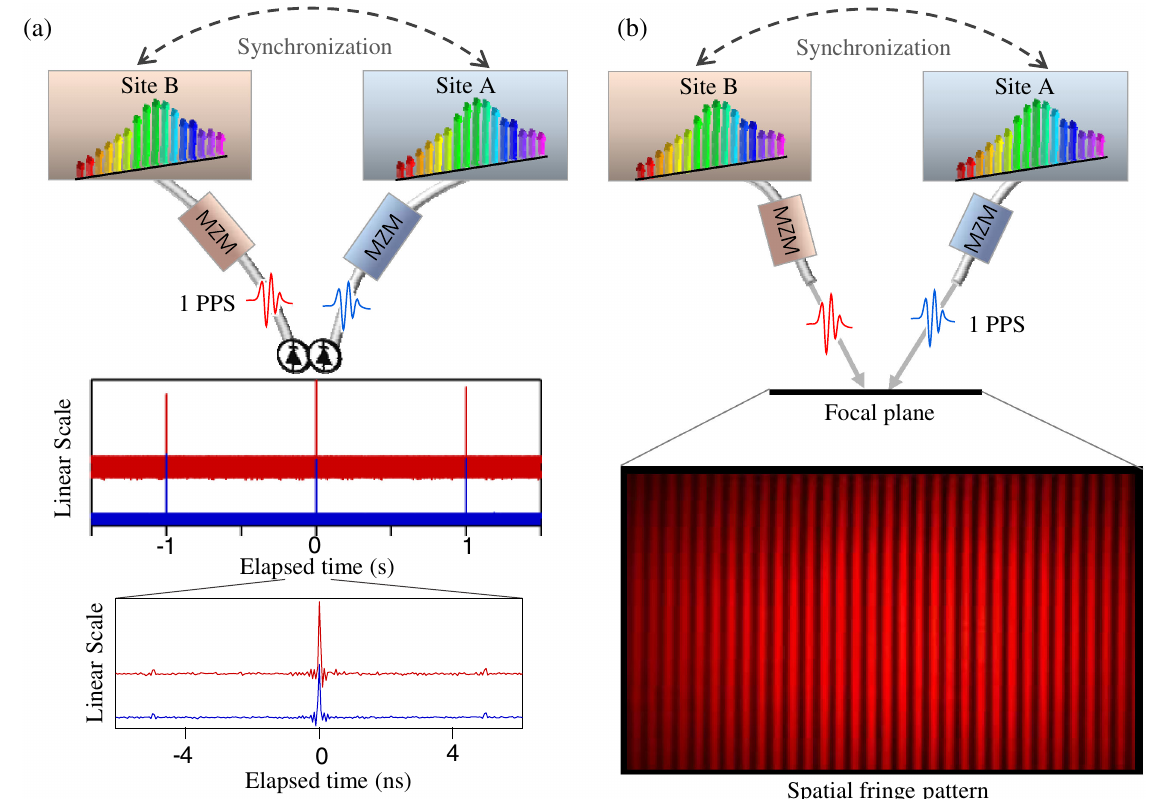
FIG. 8. Demonstration of synchronous optical pulse-per-second (PPS) outputs. (a) Synchronous optical PPS photodetection at 8-GHz bandwidth. (b) Optical interference between selected pulse bursts measured through the tilt interference pattern on a focal plane array. The strong interference demonstrates that the pulses arrive well within their correlation time of ∼ 300 fs. (See also Video 1). MZM, Mach-Zehnder